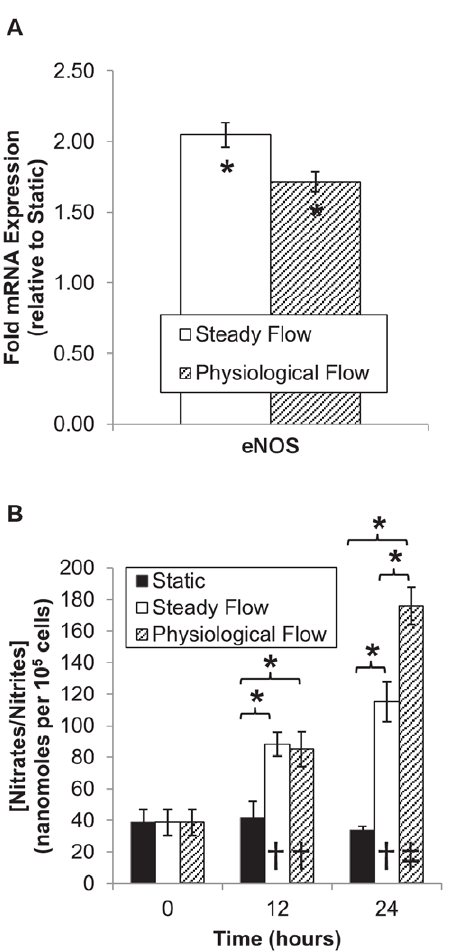
Figure 7. eNOS function in flow-conditioned endothelial cells. (A): eNOS mRNA expression (presented as mean 6 S.E.M.) was upregu- lated under either perfusion condition, but no statistical difference between flow groups was observed. (B): After 0, 12, or 24 hours of conditioning, media was collected and samples analyzed using a fluorometric assay. Total NO byproduct accumulation was normalized by the mean cell count at the end of each period. Results are displayed as mean 6 SEM (n=4–6). Asterisks denote significant differences in individual means between groups at each time point. Dagger ( { ) denotes a significant difference in mean with respect to t=0 hours. Double dagger ( { ) denotes significance with respect to t=0 and t=12 hours.